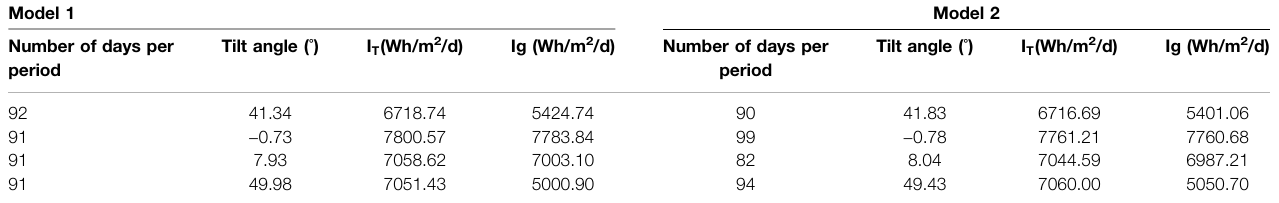
TABLE 5 | Optimal results found for Yanbu city for NP (cid:1) 4.